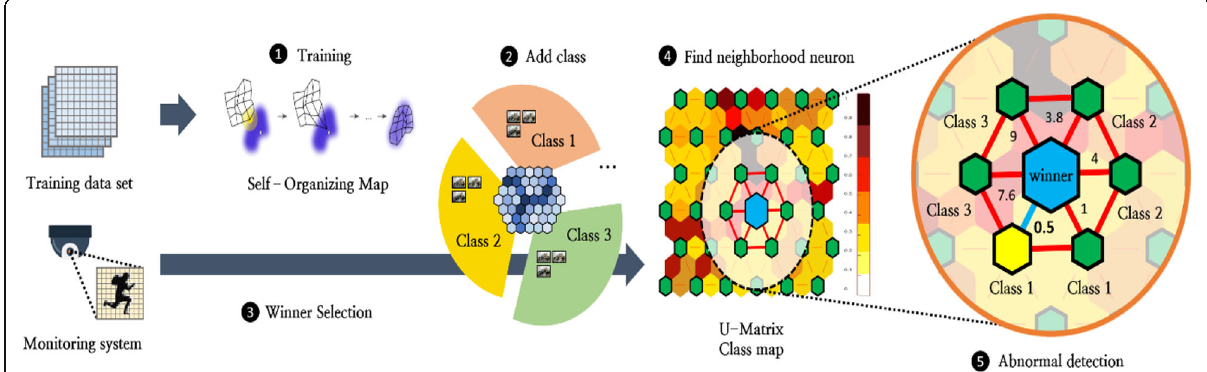
Fig. 2 Change detection process of the proposed CDAS